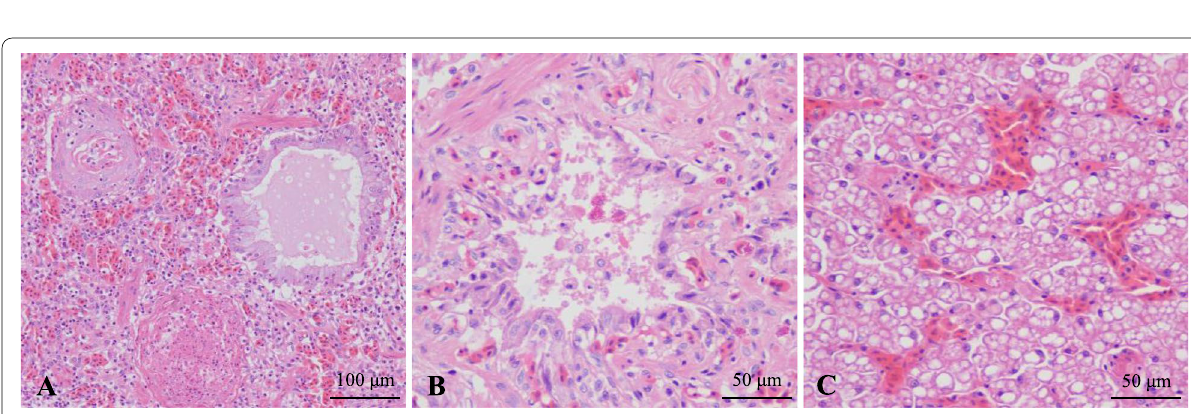
Fig. 3 Histopathological examination. A and B show infected lung tissue, and C shows liver tissue; A shows pulmonary hyperemia and fibrosis; B shows pulmonary epithelial cells falling off the alveolus; C shows hepatocyte